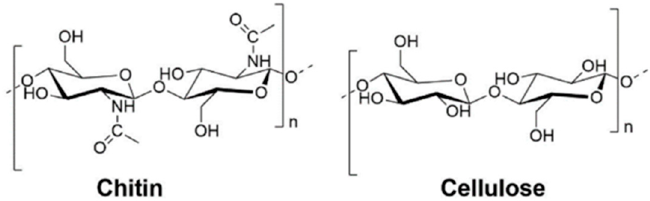
Figure 1. Chemical structure of chitin ( left ) and cellulose ( right ).